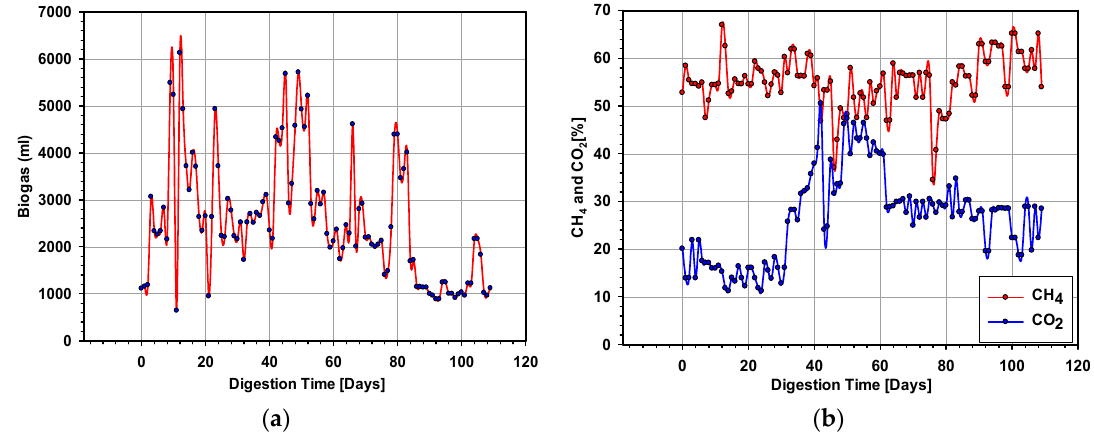
Figure 2. ( a ) Daily biogas yields with respect to the digestion time. ( b ) The contents (%) of CH 4 and CO 2.